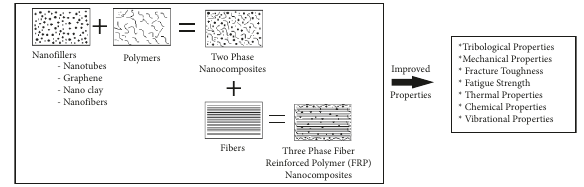
Figure 1: Scenario of property improvement by adding nanofillers with polymer and